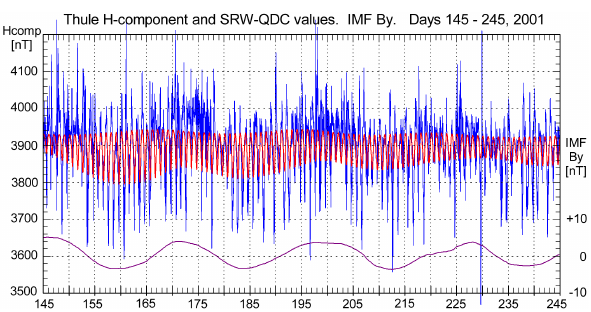
Figure 7. Strong reverse convection cases illustrated by the monthly sums of intensity times duration ([nT × h]) for strongly negative values ( (cid:49)F PROJ (QDCcorr)< − 50nT) of the projected horizontal deviations for Thule (blue line) and Vostok (red). (Note: no Vostok data in 2003).